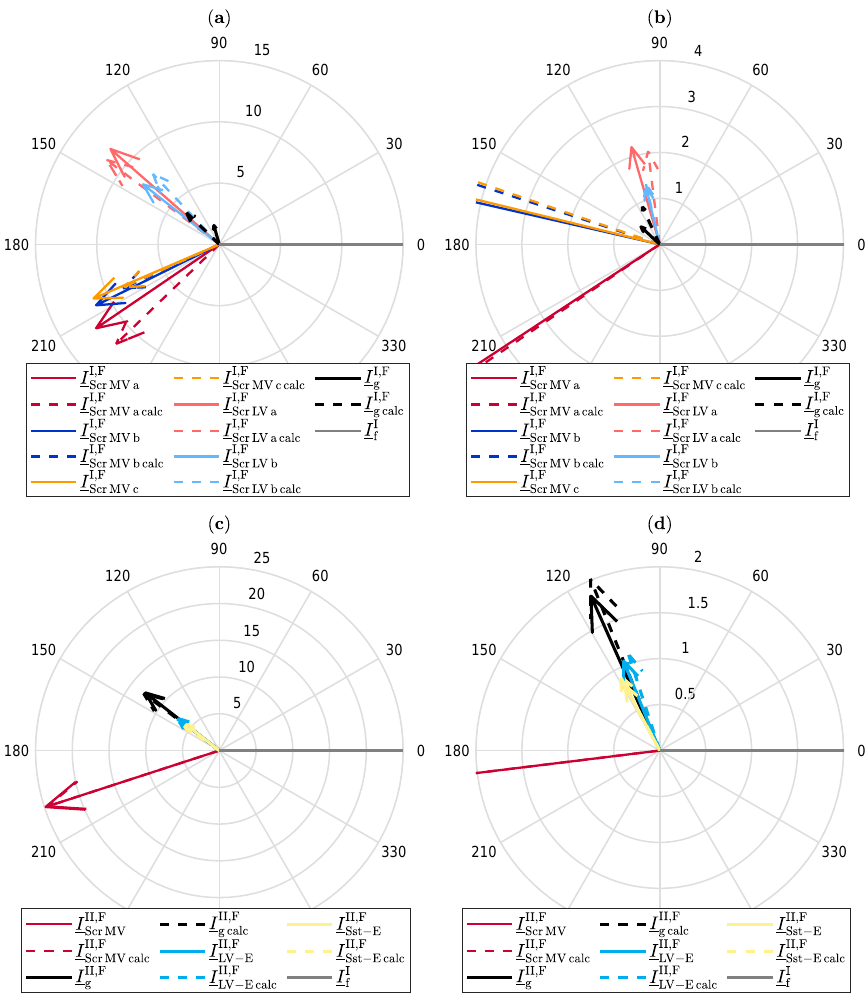
Figure 9. Comparison of the measured and calculated current shares (values in A): ( a ) Setup I, 50-Hz component, ( b ) Setup I, 250-Hz component, zoomed, ( c ) Setup II, 50-Hz component, ( d ) Setup II, 250-Hz component,